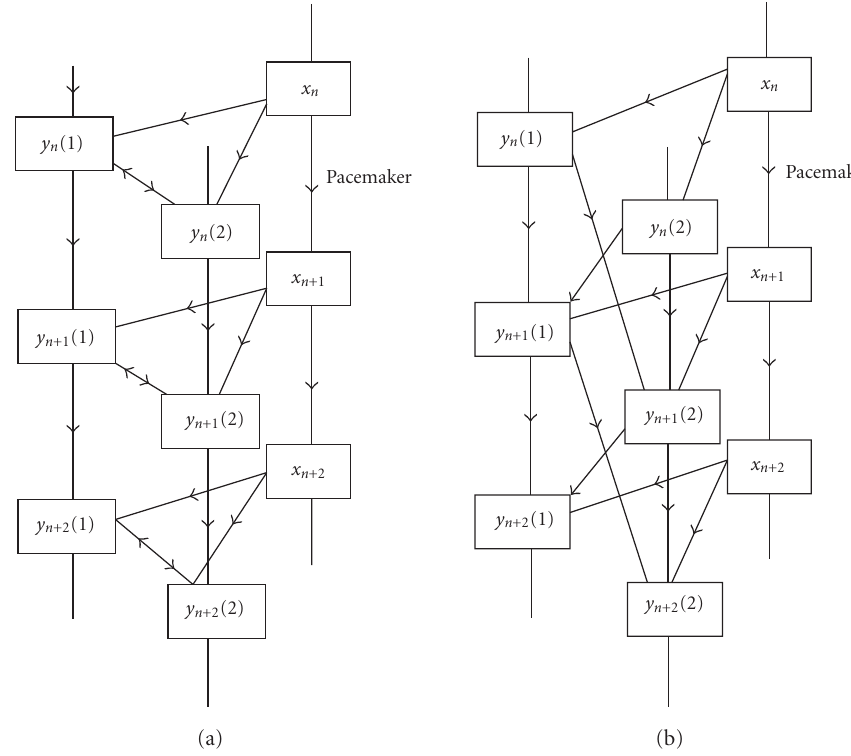
Figure 2.3. Schematic illustration of the two di ff erent types of coupling in system of two coupled maps with a pacemaker: dissipative (a) and inertial